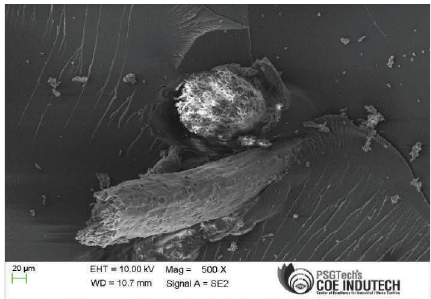
Figure 9: Fractured SEM images of unmodifed hybrid